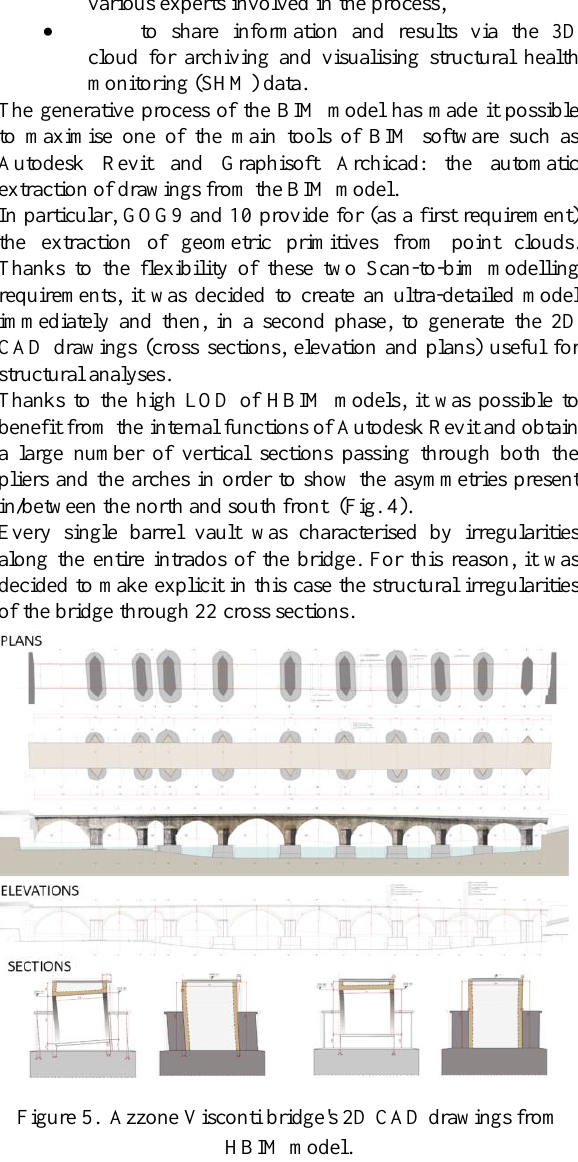
Figure 4. Azzone Visconti bridge's point clouds o and its geometric irregularities.